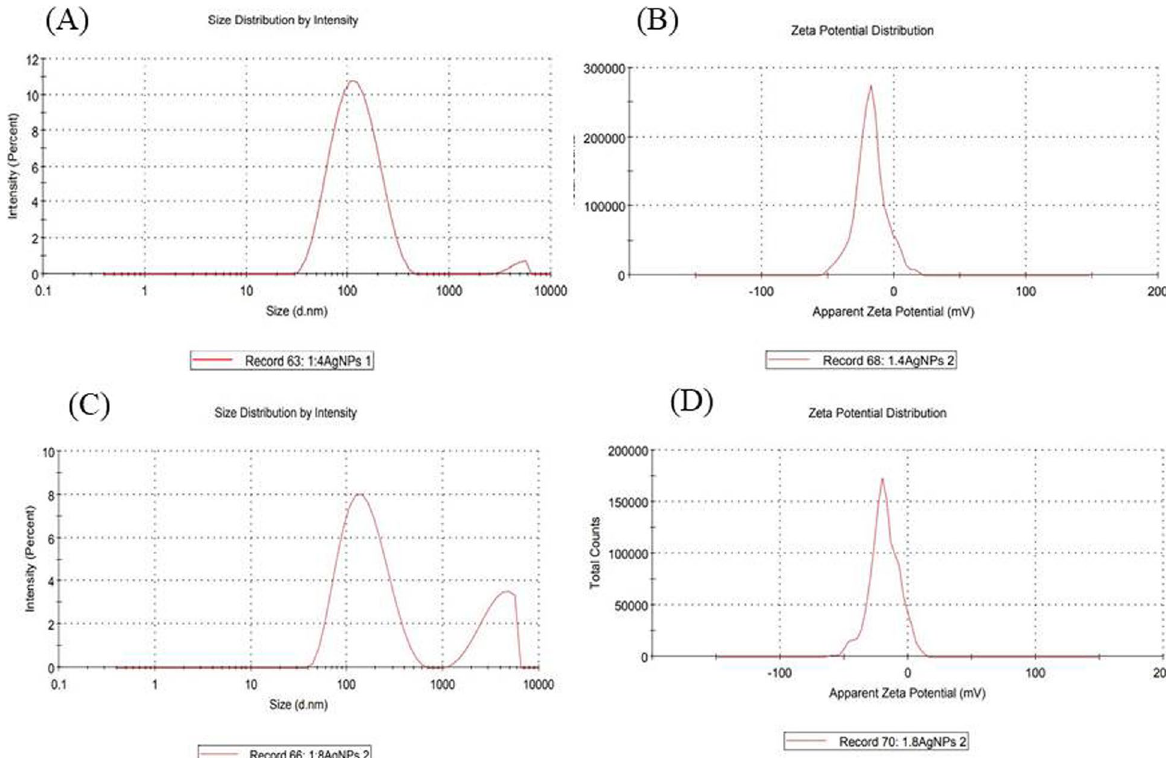
Fig. 5 DLS analysis for ( A ) size of 1:4 AgNPs ( B ) zeta potential of 1:4 AgNPs and ( C ) Size of 1:8 AgNPs ( D ) zeta potential of 1:8 AgNPs synthesize from Polygonum plebeium leaf extract